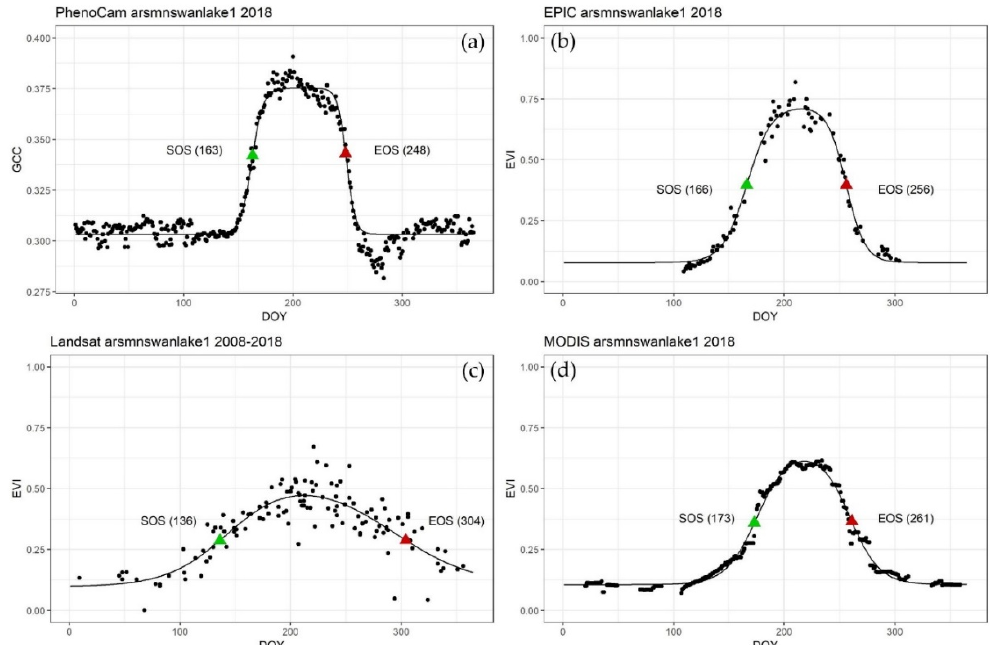
Figure A1. Derived vegetation phenology indicators of SOS and EOS from EVI for agriculture study site ‘arsmnswanlake1’ based on ( a ) PhenoCam, ( b ) EPIC, ( c ) Landsat, and ( d ) MODIS observations. The green triangles indicate SOS, and the red triangles indicate EOS for each time series. The y-axis scale was kept constant for Landsat, MODIS, and EPIC, but adjusted for PhenoCam to better show the shape of the curve.